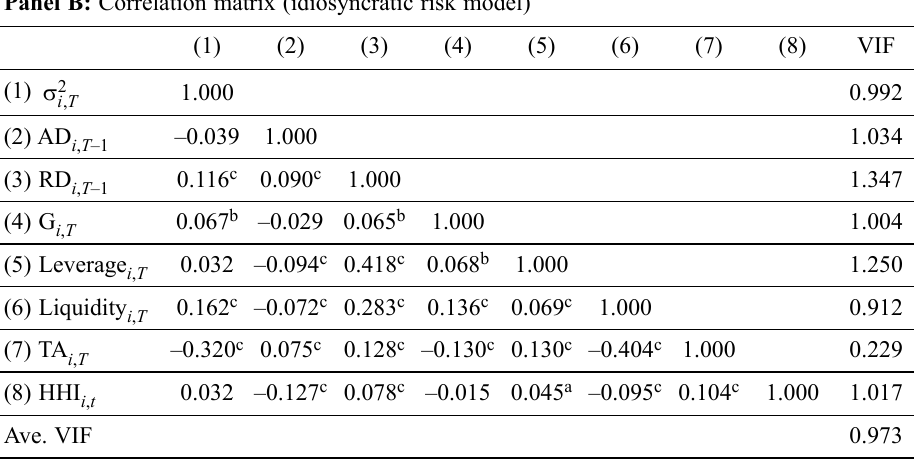
Panel B: Correlation matrix (idiosyncratic risk